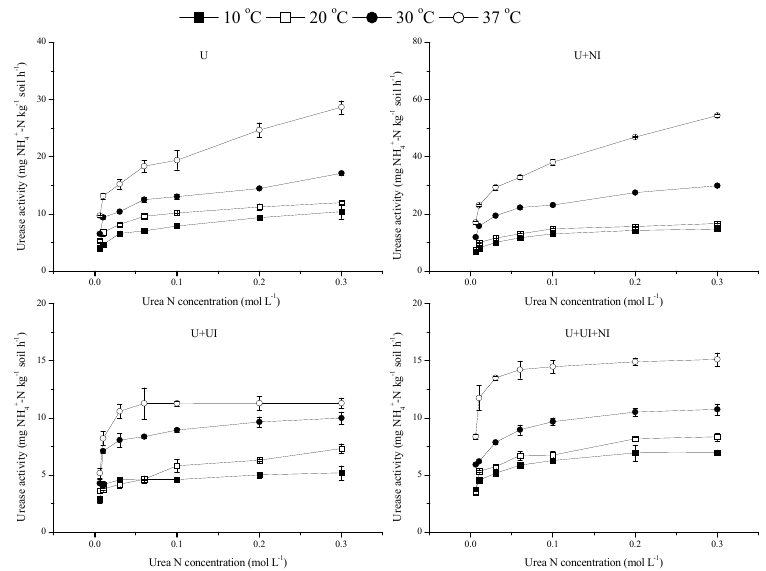
Figure 4. Effect of temperature and urea concentration on the urease activity. Bars represent the standard error ( n = 4). U, U + NI, U + UI, and U + UI + NI represent the four urea types: conventional urea, nitrification inhibitor treated urea, urease inhibitor treated urea, and urease/nitrification inhibitor treated urea, respectively, in the incubation. Error bars indicate standard error ( n = 4). Table 2. Effect of temperature and urea type on Michaelis–Menten kinetic parameters (Equation (3)). Treatment Temperature ( ◦